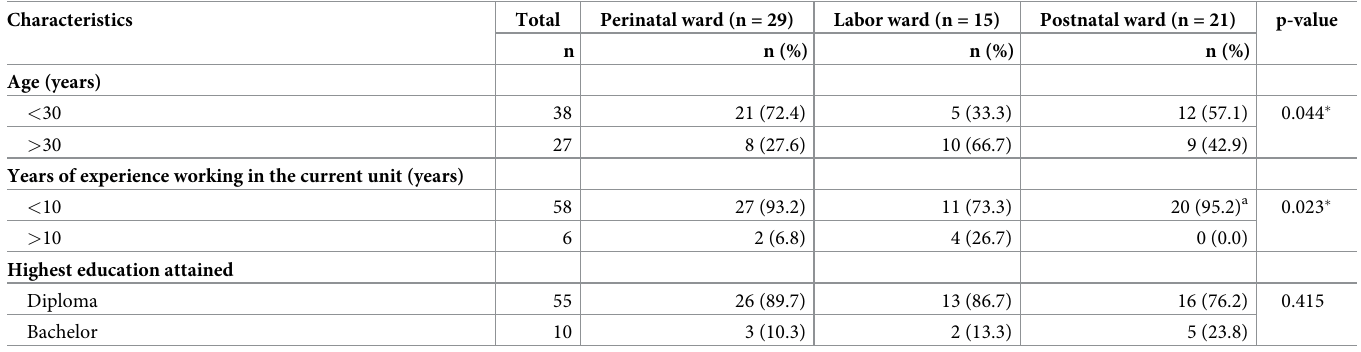
Table 1. Nursing staff